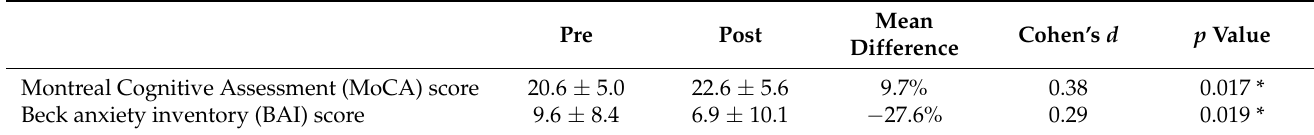
Table 3. Statistical analysis results of the Montreal Cognitive Assessment (MoCA) and Beck Anxiety Inventory